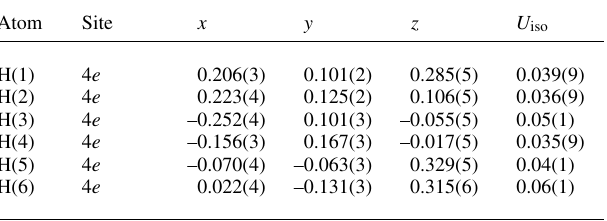
Table 7. Data collection and handling. Table 8. Atomic coordinates and displacement parameters (in Å 2 ) .